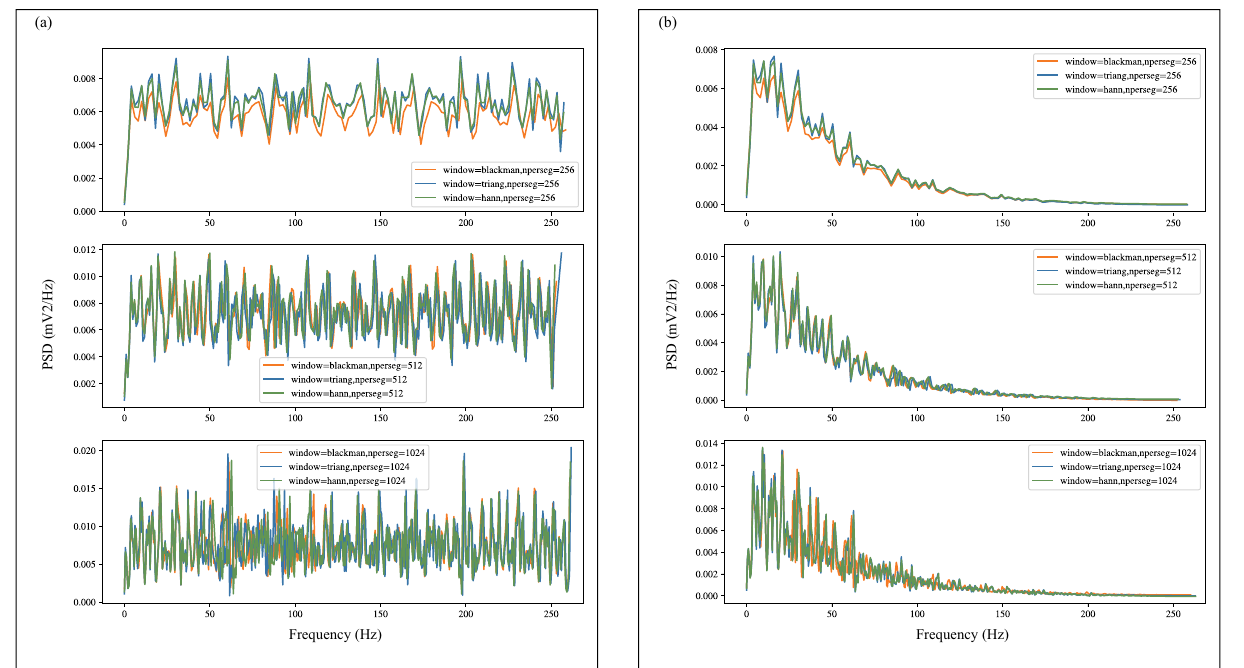
Figure 4. Power spectral density curves obtained by applying Welch with different windows and different window lengths. Windows include Blackman window, Hanning window, and Triangular window. And window lengths include 256, 512, and 1024. ( a ) Power spectral density curve of the lead I signal of the abnormal sample before filtering. ( b ) Power spectral density curve of the lead I signal of the abnormal sample after filtering. Each subplot uses the same window length and a different